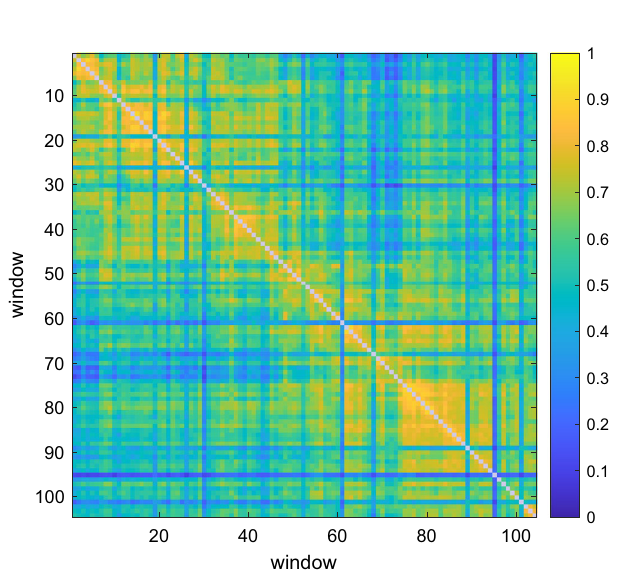
Figure 4. The Pearson correlation between adjacency matrices at different time windows. The element c ij = ρ( A i , A j ) of the matrix is the Pearson correlation between the vectorized adjacency matrices at windows i and j . High values of c ij indicate that the structure of the network at windows i and j is very similar. Diagonal elements, indicating self-correlation, are colored in